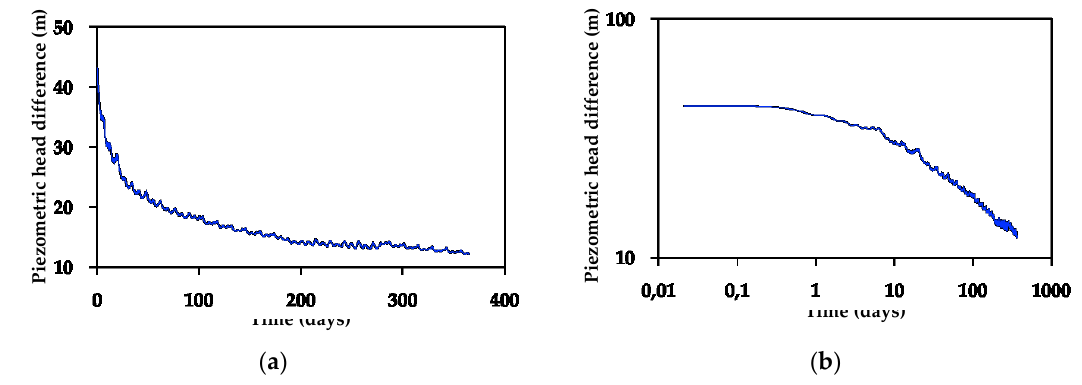
Figure 8. Difference of the piezometric head evolution between scenarios F-CI and E-CI in an observation point located at 15 m upgradient from the underground reservoir and at 105 m depth. ( a ) Results are plotted with linear axis; ( b ) shows the piezometric head difference evolution with logarithmic axis.